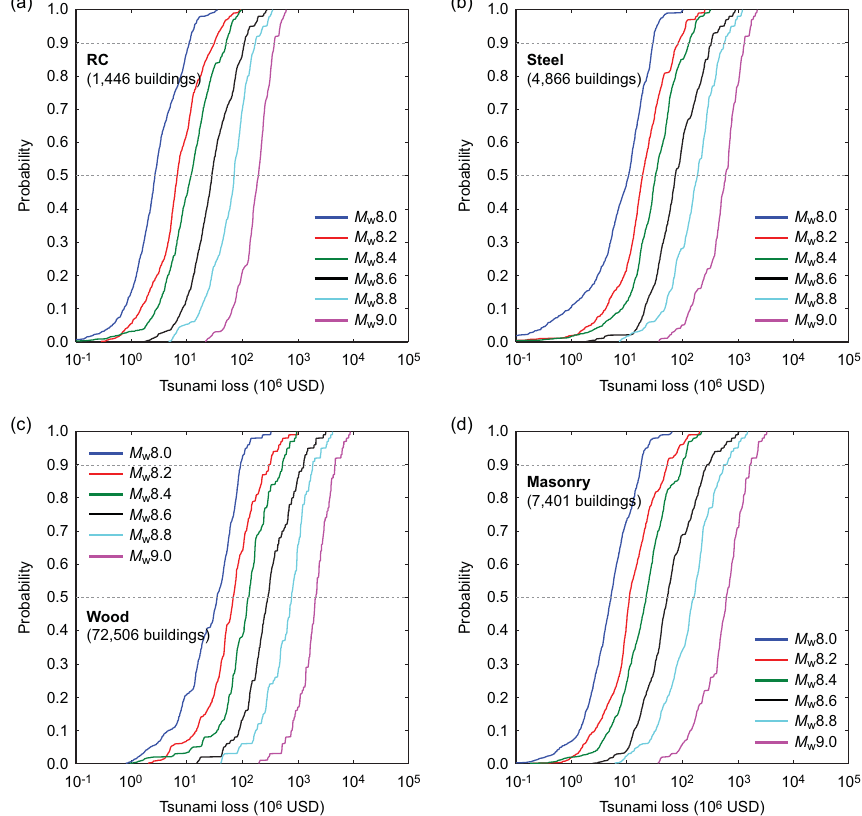
Figure 7. Probability distributions of tsunami loss for different earthquake scenarios by distinguishing material types: (a) RC, (b) steel, (c) wood, and (d) masonry.